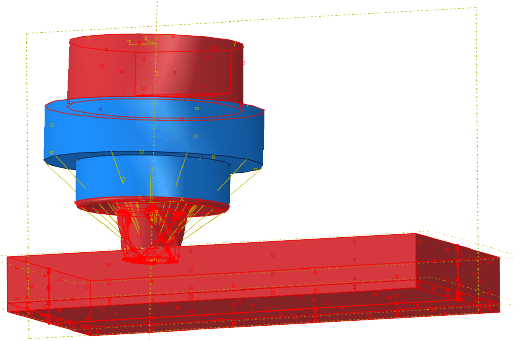
Figure 6. Areas defined for heat conduction ( red ) and convection ( blue ) on tool and